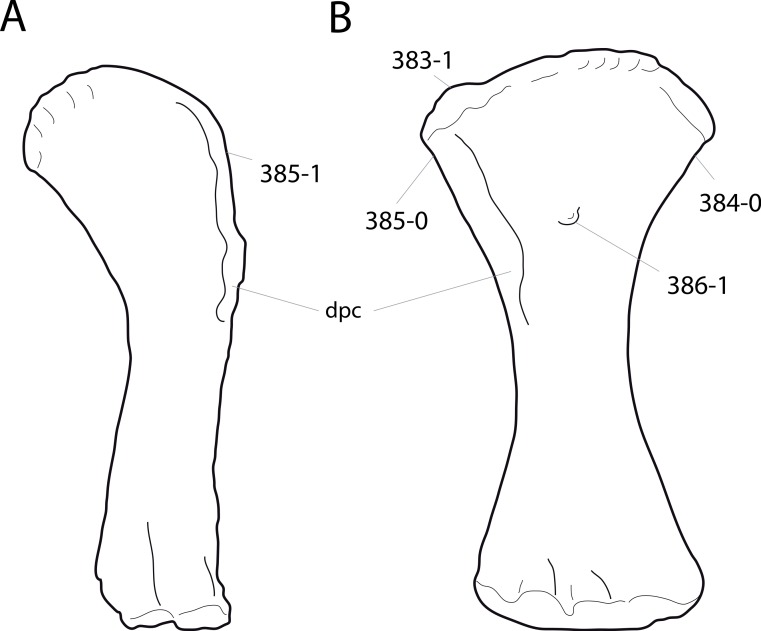
Eusauropod humeri.Humeri of Turiasaurus riodevensis CPT 1195 (A; traced from Royo-Torres, Cobos & Alcalá, 2006) and Suuwassea emilieae ANS 21122 (B; traced from Harris, 2007) in anterior view. Note the pronounced proximolateral corner (B; C383-1), the symmetrical proximal transverse expansion (B; C384-1), the unexpanded (A; C385-1) or expanded lateral edges (B; C385-0), and the tubercle marking the center of the proximal concavity (B; C386-1). Abb.: dpc, deltopectoral crest. Scaled to same length.